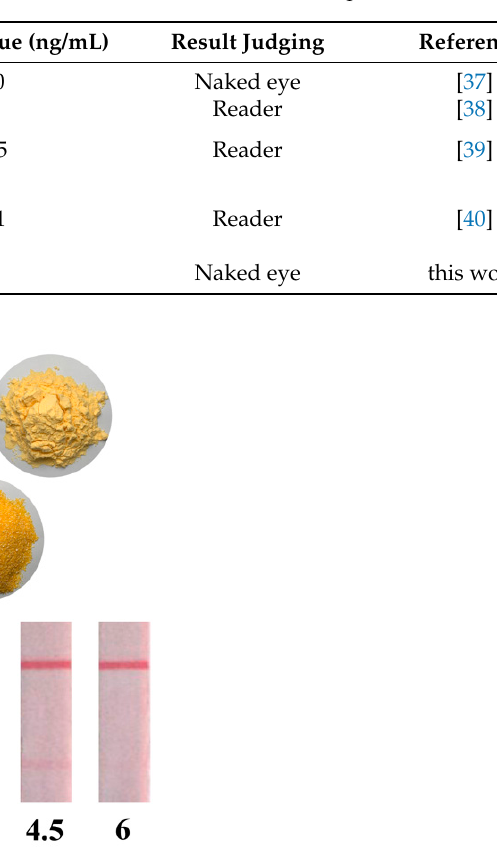
Figure 3. The sensitivity of PMs-ICA for detection of AFB 1 in PB. Result for AFB 1 standard of different concentrations, by the naked eye, and calibration curve of B/B 0 against the concentration of AFB 1 . Table 1. Comparison of performances and convenience of LFICAs for AFB 1 detection.